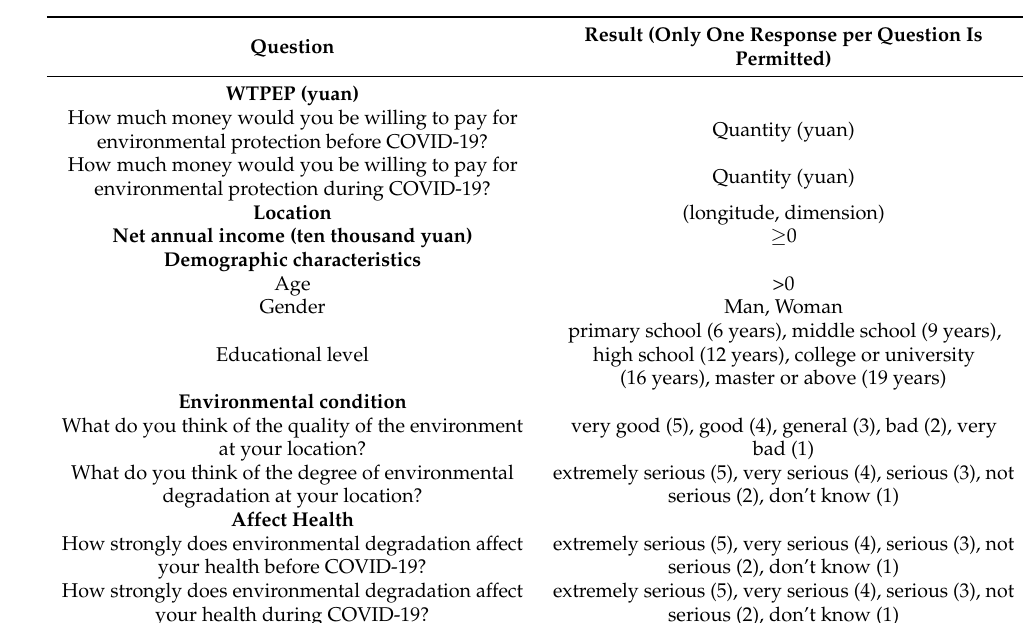
Figure 1. Location of the study area and distribution of confirmed cases of COVID-19 up to 31 August 2022. Table 1. Content of the questionnaire